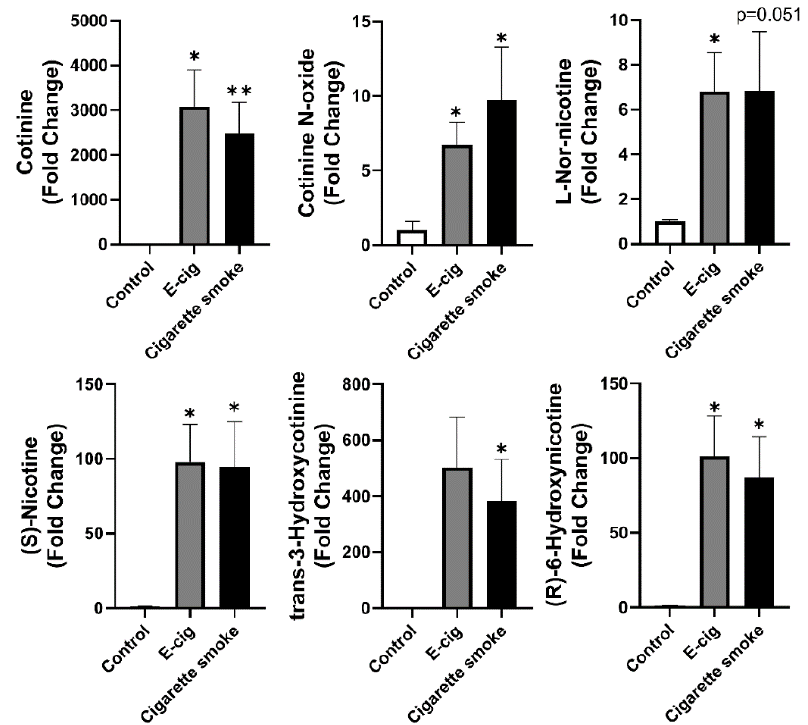
Figure 3. Metabolites from plasma analyzed from UPLC-MS from positive ion mode identified dysregulated nicotine degradation related metabolites in e-cig users and cigarette smokers. Fold changes were calculated based on the normalized area from UPLC-MS spectra, and control groups were used as a baseline. Data are shown as mean ± SEM ( n = 6 for non-smoking control and cigarette smoke groups, n = 12 for e-cig group; * p < 0.05, ** p < 0.01 vs. control non-smokers).